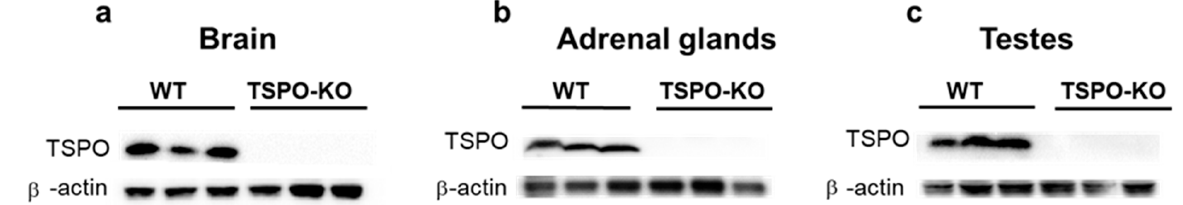
Figure 7. Western blot analysis of TSPO/PBR in tissues from male WT and TSPO-KO mice. Representative bands of TSPO/PBR and the loading control β -actin for the brain ( a ), adrenal glands ( b ) and testes ( c ) are shown.